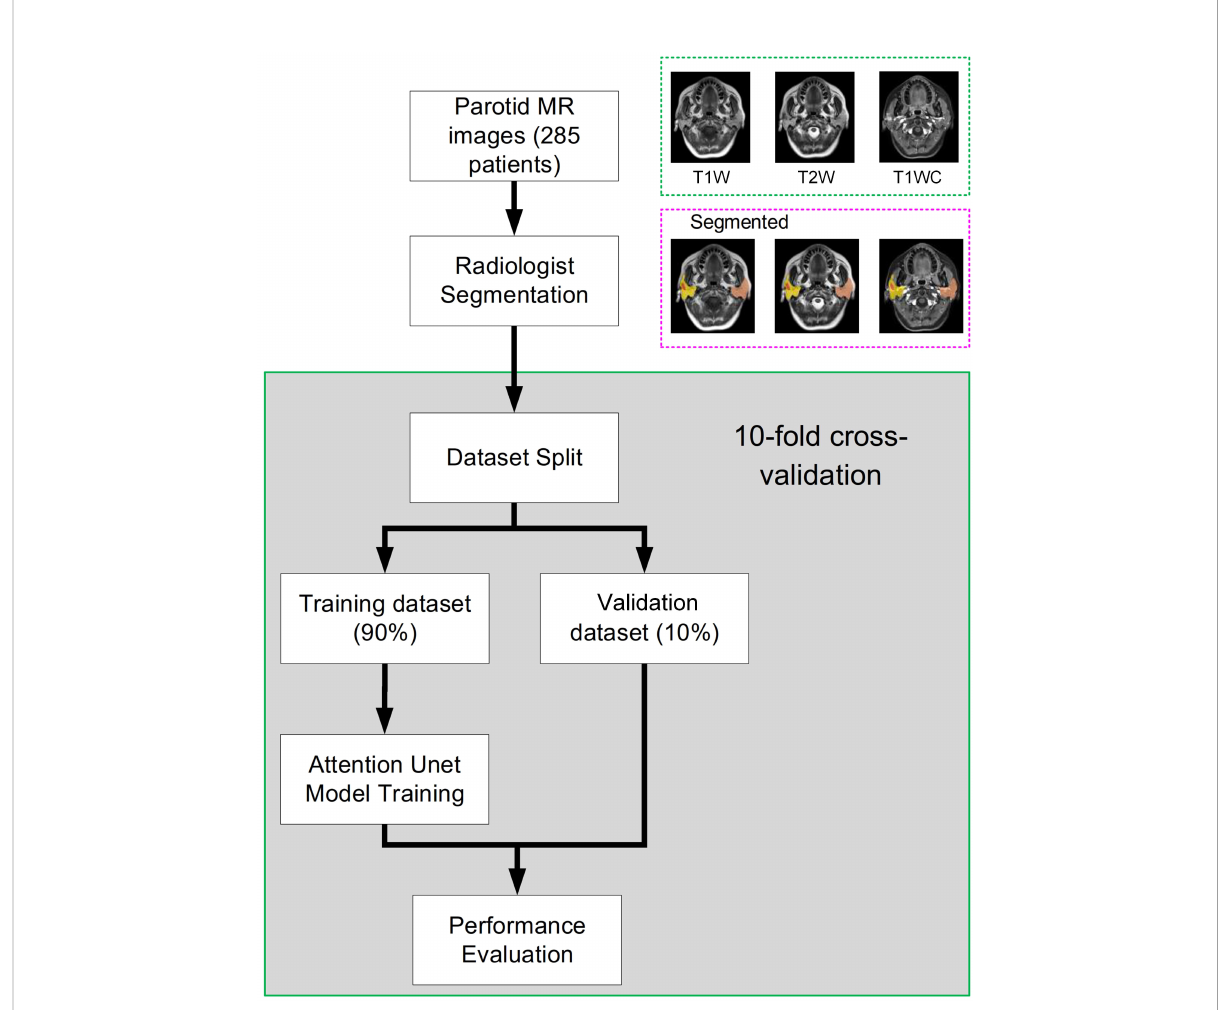
FIGURE 1 The whole study work fl ow. The parotid MR images were randomly divided into two datasets, including training and evaluation. Then, the performance was assessed on the validation dataset. Tenfold cross-validation was used to obtain a reliable result.